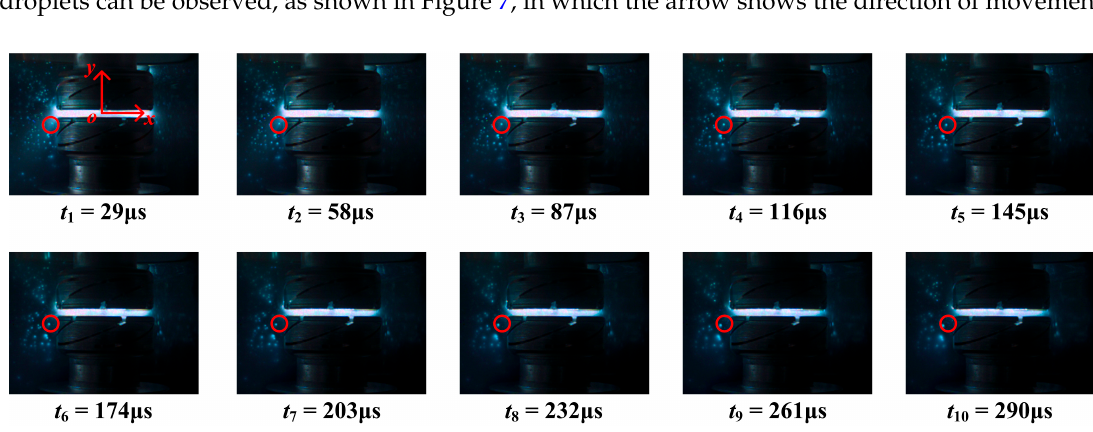
Figure 6. Droplet emission and movement during arc reignition (360 Hz).